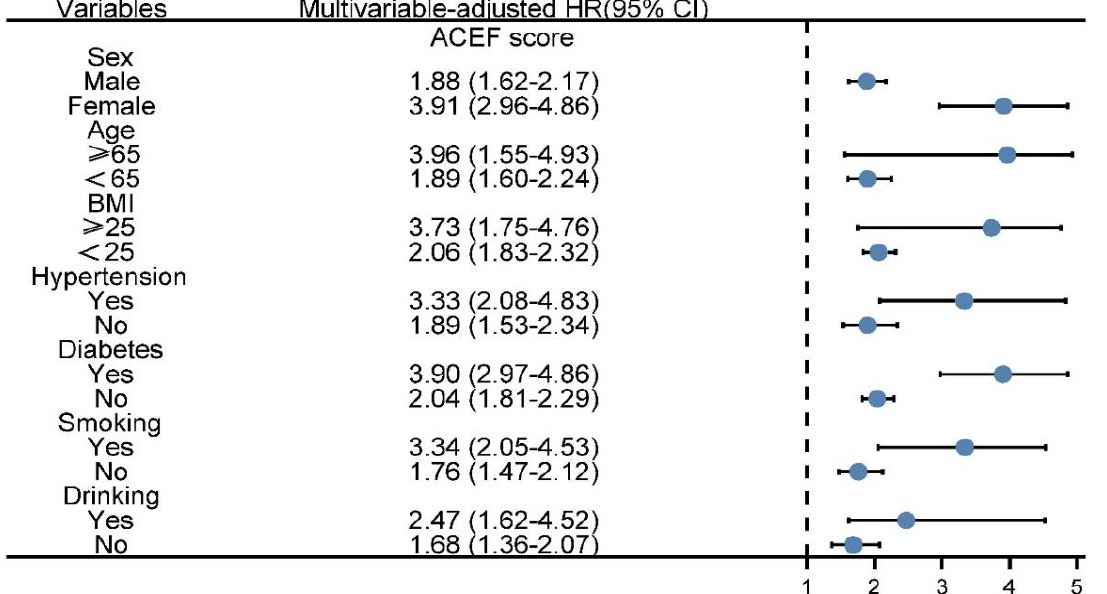
Table 3. Discrimination and reclassification for CVD with the addition of ACEF to traditional risk factors model.